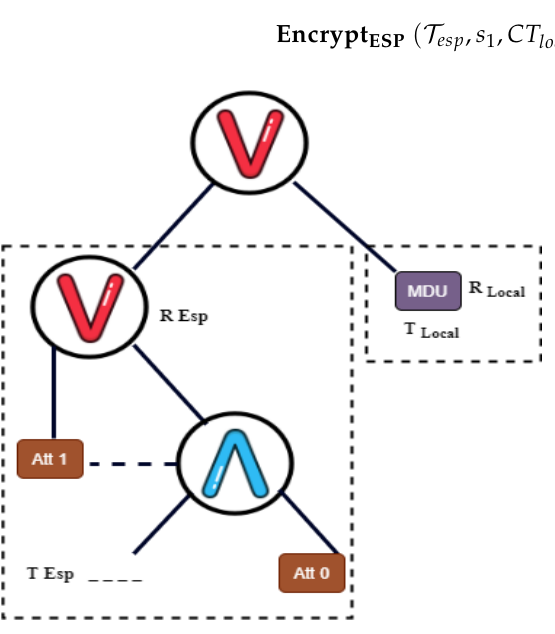
Figure 3. Access policy with